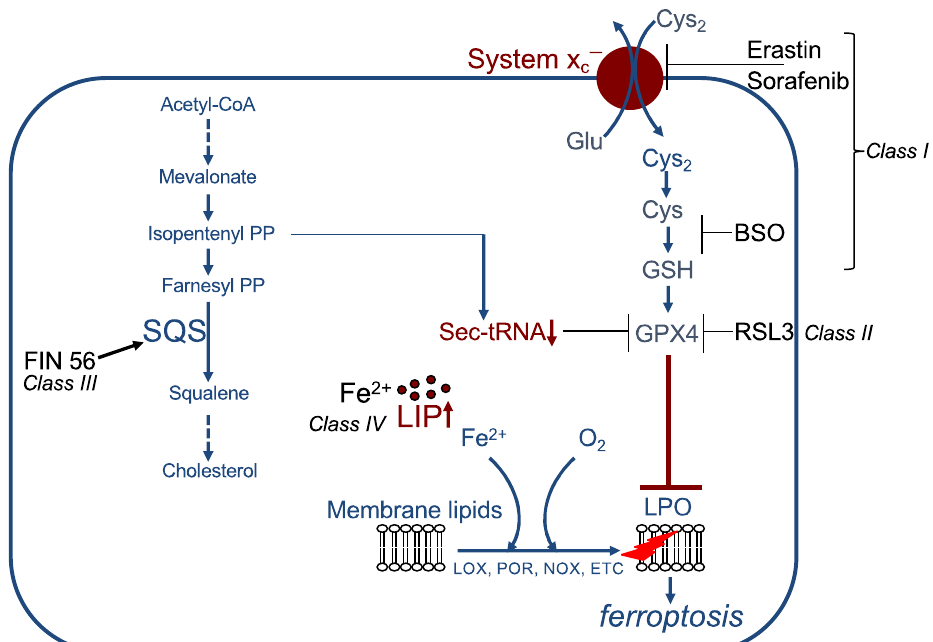
Figure 3. Examples of ferroptosis inducers (FINs). Class I FINs act by decreasing GSH levels. Class II FINs directly inhibit GPX4. Class III FINs indirectly block GPX4 activity. Class IV FINs increase the labile iron pool (LIP). See text for details. SQS: squalene synthase, LIP: labile iron pool, LPO: lipid peroxidation, PP: pyrophosphate.